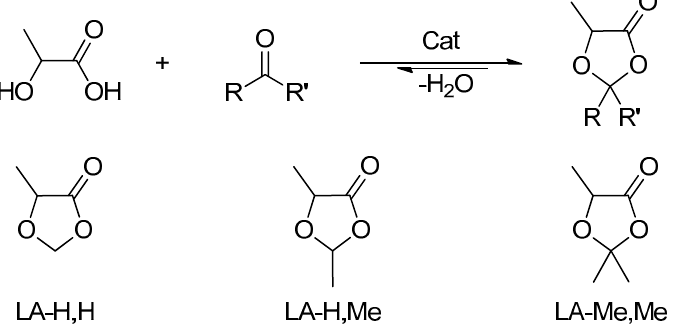
Figure 2. DOLOs synthesis and investigated solvent. 5-methyl-1,3-dioxolan-4-one LA-H,H; 2,5- dimethyl-1,3-dioxolan-4-one LA-H,Me; 2,2,5-trimethyl-1,3-dioxolan-4-one LA-Me,Me.